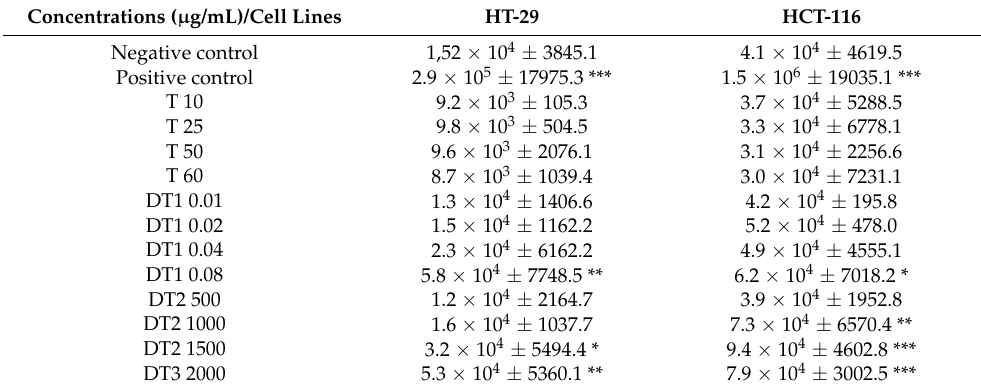
Table 1. Effect of thymol (T), acetic acid thymol ester (DT1), and thymol β -D-glucoside (DT2) after 24 h on ROS production in HT-29 and HCT-116 cell lines. Concentrations ( µ g/mL)/Cell Lines HT-29 HCT-116 Negative control 1,52 × 10 4 ±